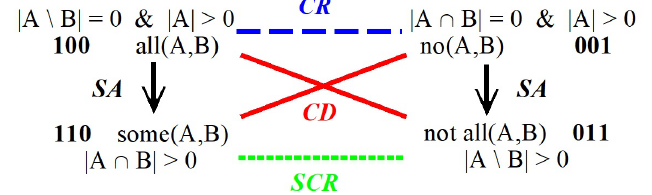
Figure 7. Classical square with bitstrings of length 3 for F all , relative to SYL